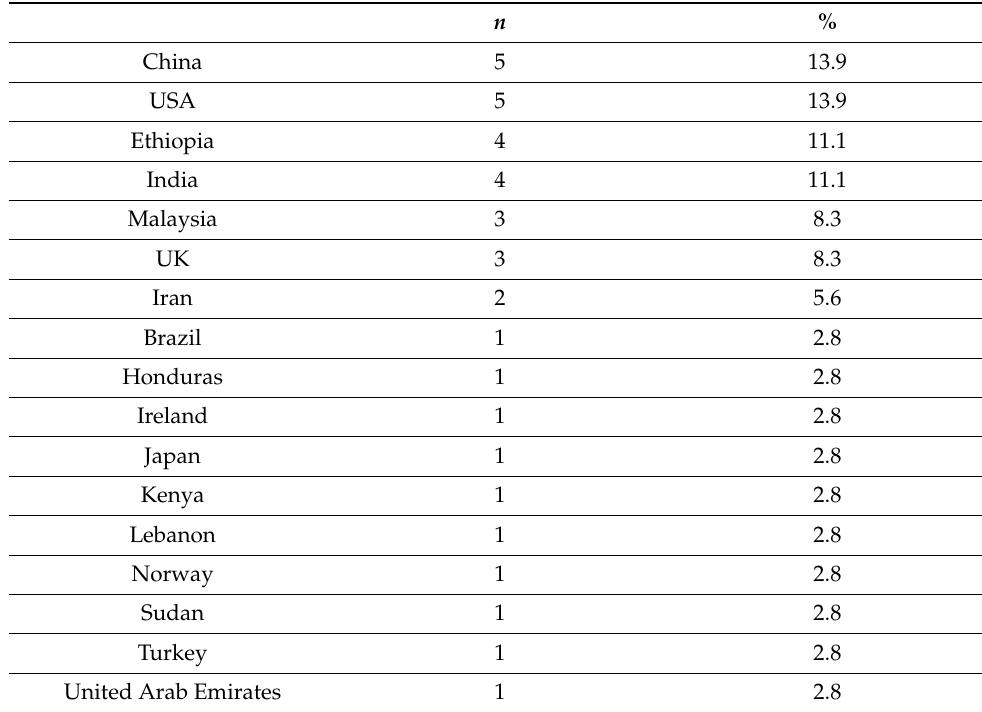
Table 3. Overview of the distribution of epilepsy by